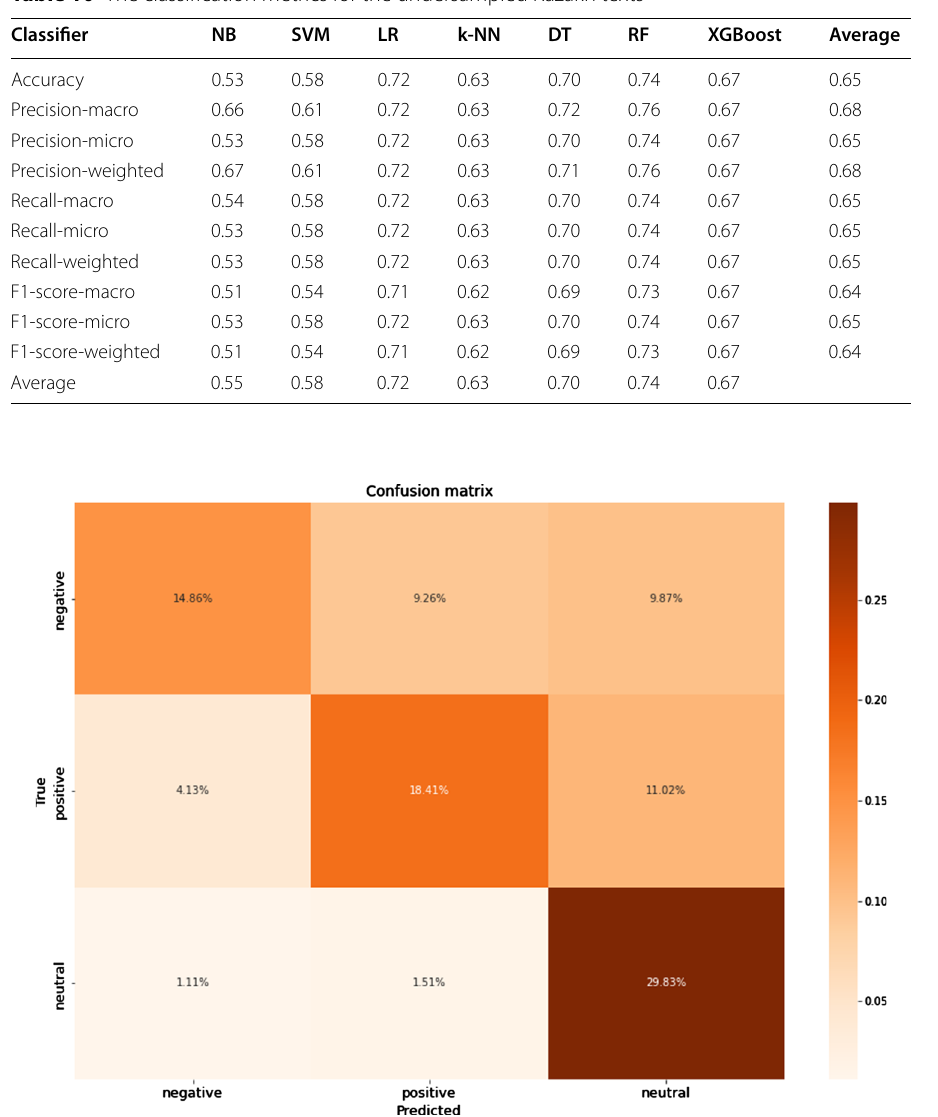
Table 10 The classification metrics for the undersampled Kazakh texts